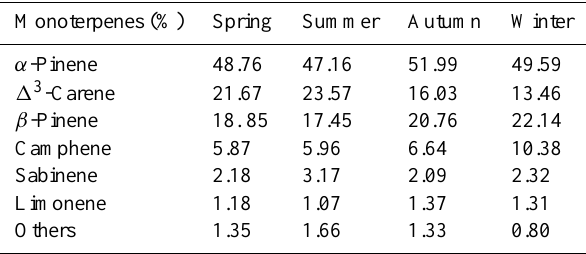
Figure 10. Modelled (MEGAN 2.04) and measured (Hakola et al., 2009) monoterpene composition at 14m height at the SMEAR II station in summer 2007. Table 3. Modelled (MEGAN 2.04) seasonal contributions of indi- vidual monoterpene proportions (in % to total monoterpene concen- trations) at 14m height for each season of the year 2007.